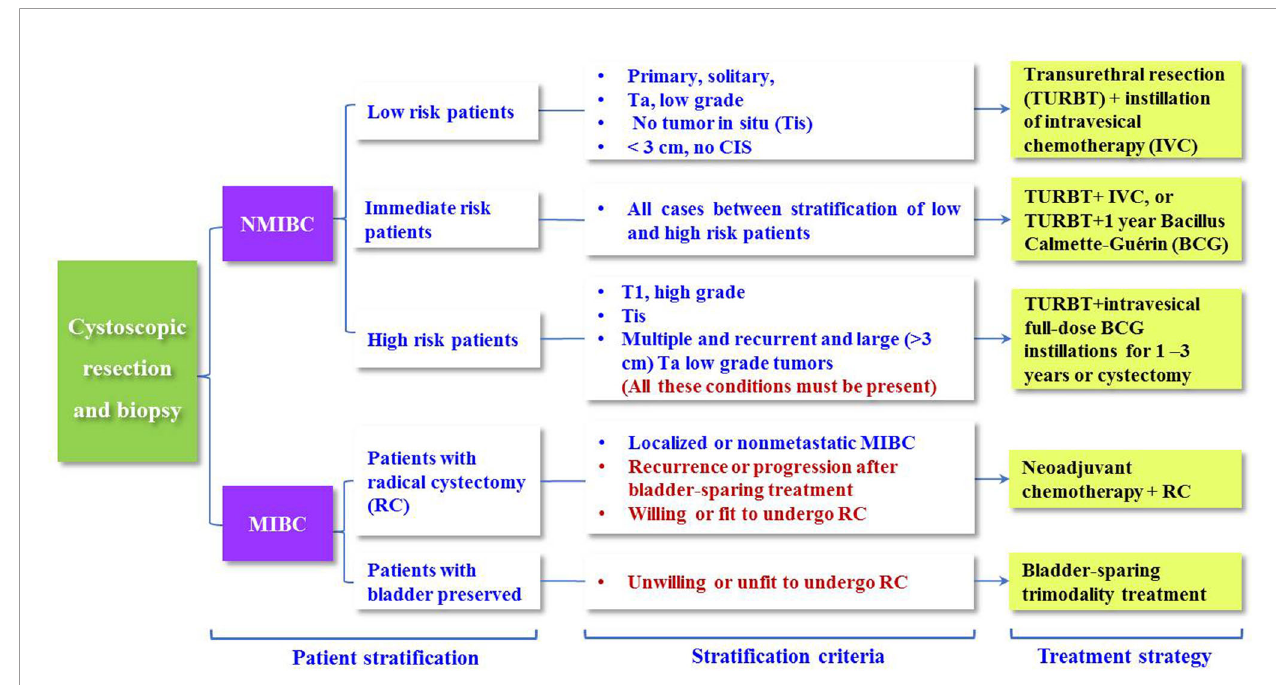
FIGURE 5 | Treatment recommendations for BCa patients based on the MIS, grade and recurrence risk strati fi